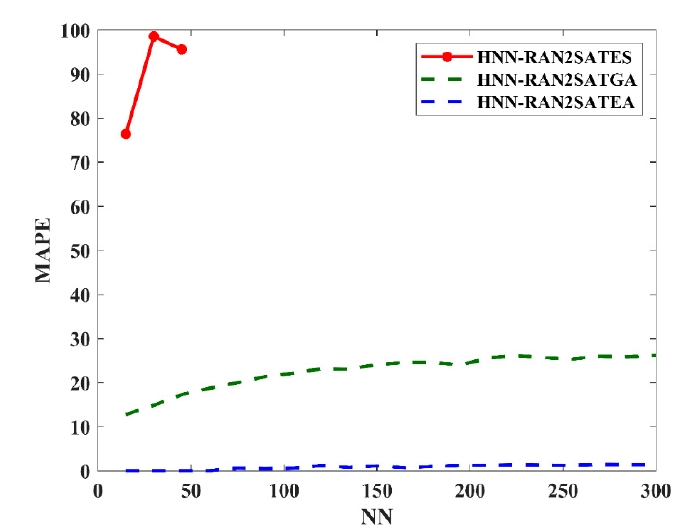
Figure 5. Mean absolute percentage error (MAPE) evaluation of various HNN-RAN2SAT models.